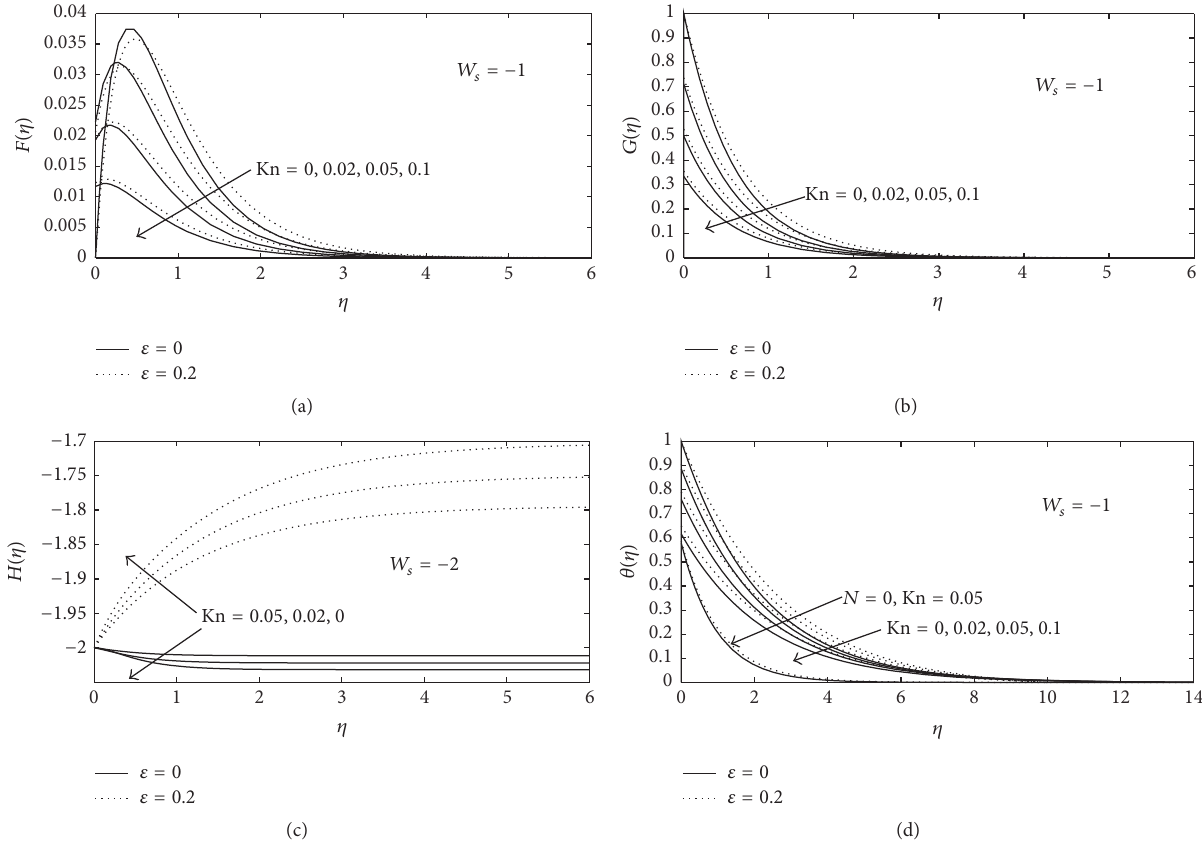
Figure 5: Effect of variation in the Knudsen number on the (a) radial, (b) tangential, (c) axial, and (d) temperature velocity profiles when 𝐾 = 1 , Re = 100, 𝑁 = 1 , and Pr = 1.